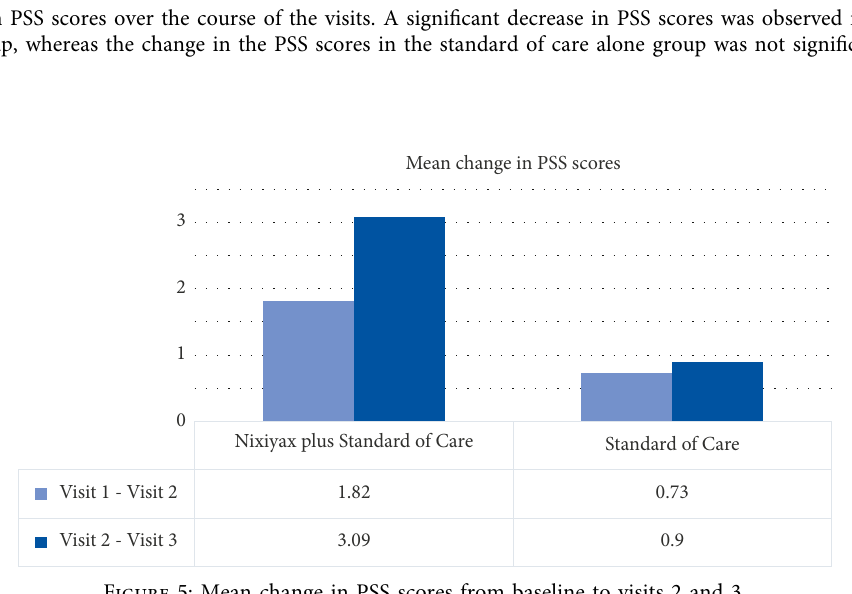
Figure 5: Mean change in PSS scores from baseline to visits 2 and 3.